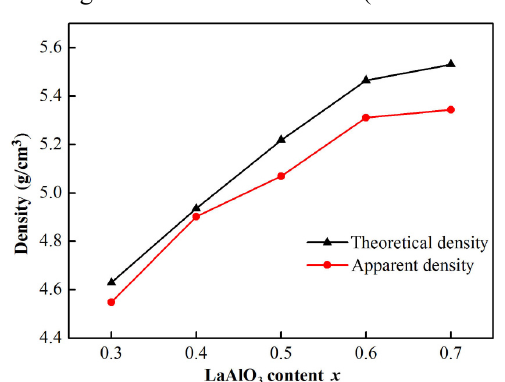
Fig. 2 Densities of the CTLA ceramics sintered at 1450 ℃ for 4